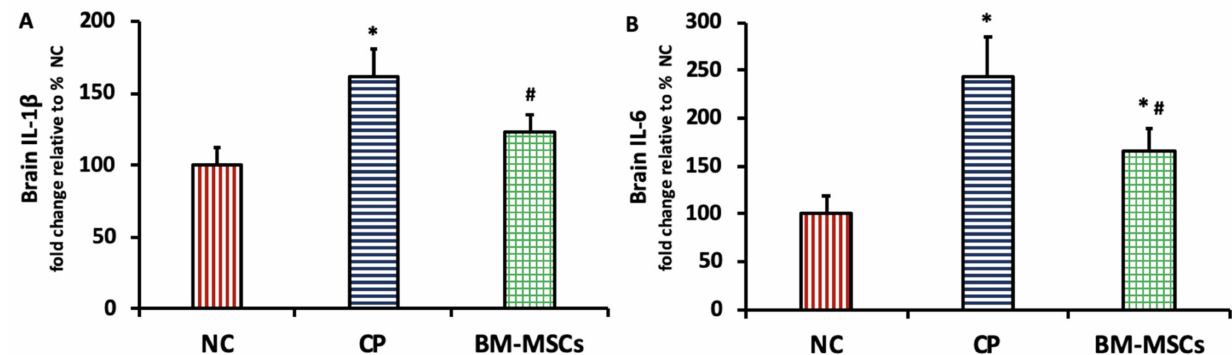
Figure 5. Impact of BM-MSCs administration on IL-1 β ( A ) and IL-6 ( B ) in the brain tissue of CP-intoxicated rats. Data are presented as mean ± SD, n = 5. * p < 0.05 vs. NC group, # p < 0.05 vs. CP group. NC: normal control, CP: cisplatin,